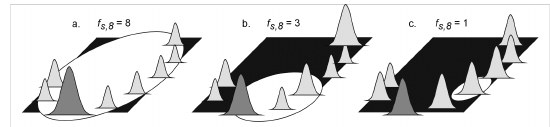
Figure 1. Concept of a saliency map and an according size of the attentional focus ( f , measured in number of s,n items) according to STRAVIS (Müller-Plath & Pollmann, 2003). For details, see